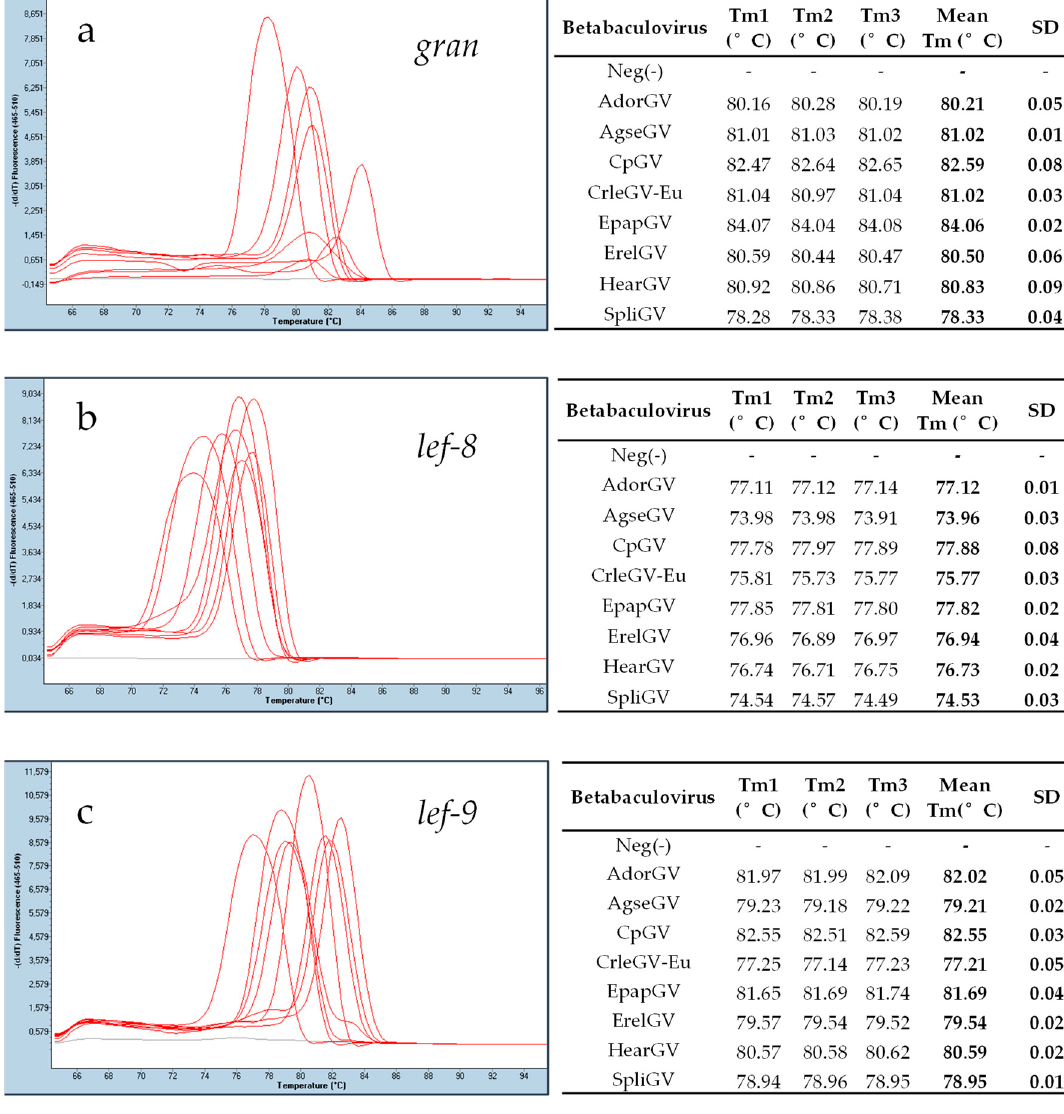
Figure 4. Real-time PCR results (melting curves) using universal pairs of primers that allow for the amplification of short fragments of three betabaculovirus genes: ( a ) granulin , ( b ) late expression factor-8 , and ( c ) late expression factor-9 . On the left side of ( a ), ( b ), and ( c ), melting curve analyses with red peaks from a single run (Tm1) are shown; the grey line represents a negative control [Neg(-)] with alphabaculovirus Lymantria dispar nucleopolyhedrovirus (LdMNPV) DNA; the X -axis represents temperatures; and the Y -axis represents –(d/dT) fluorescence (465–510 nm). On the right side of ( a ), ( b ), and ( c ), the melting temperatures (Tm) for each PCR product from three repetitions and mean Tm with SD calculated are shown.